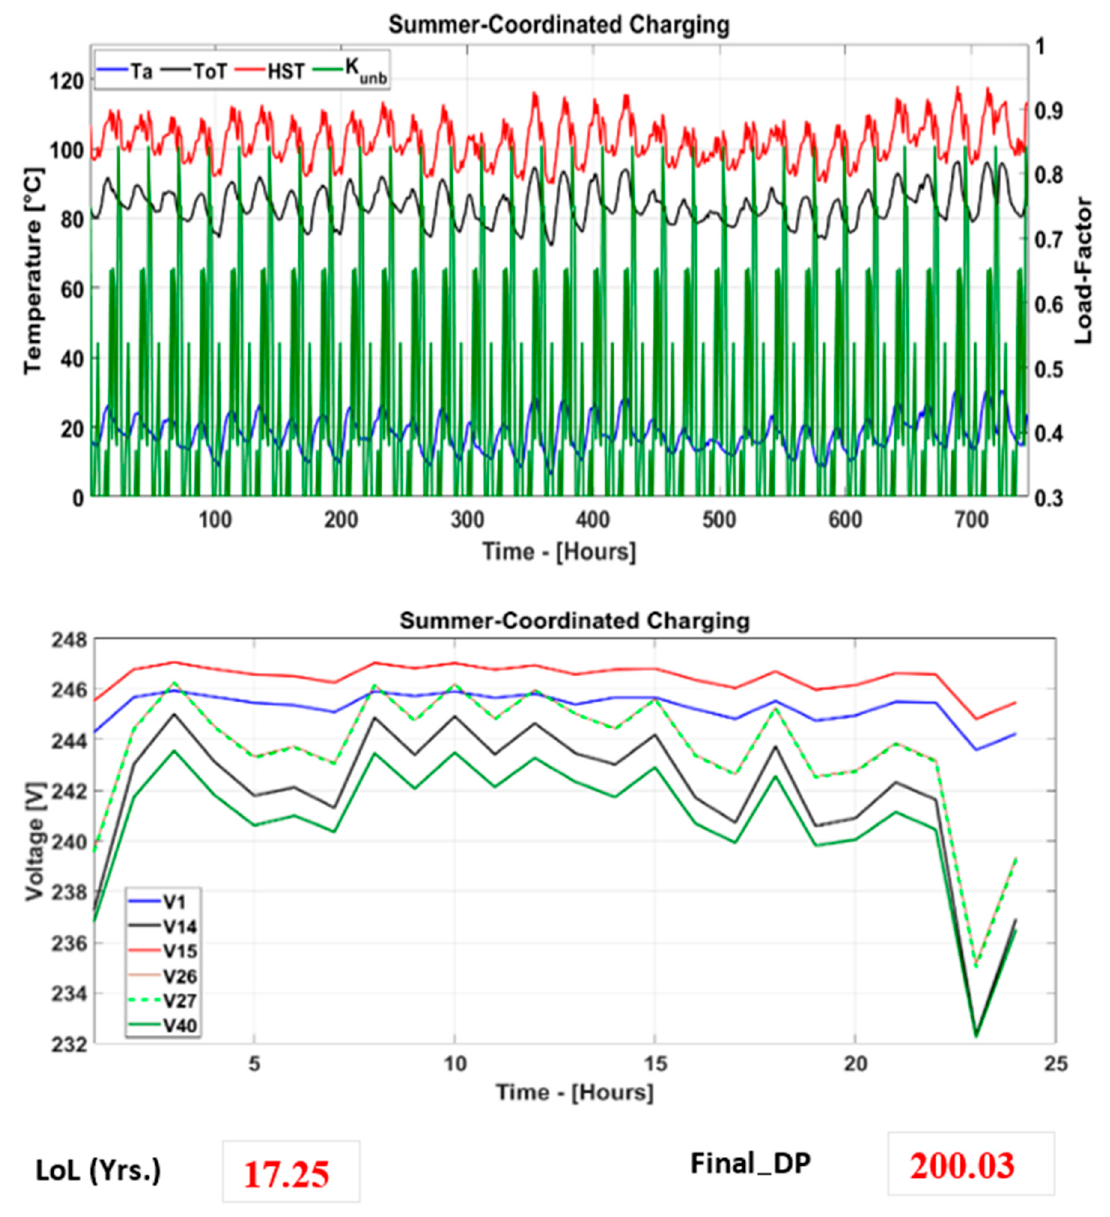
Figure 10. Output under coordinated charging across selected households, during summer, with BESS.